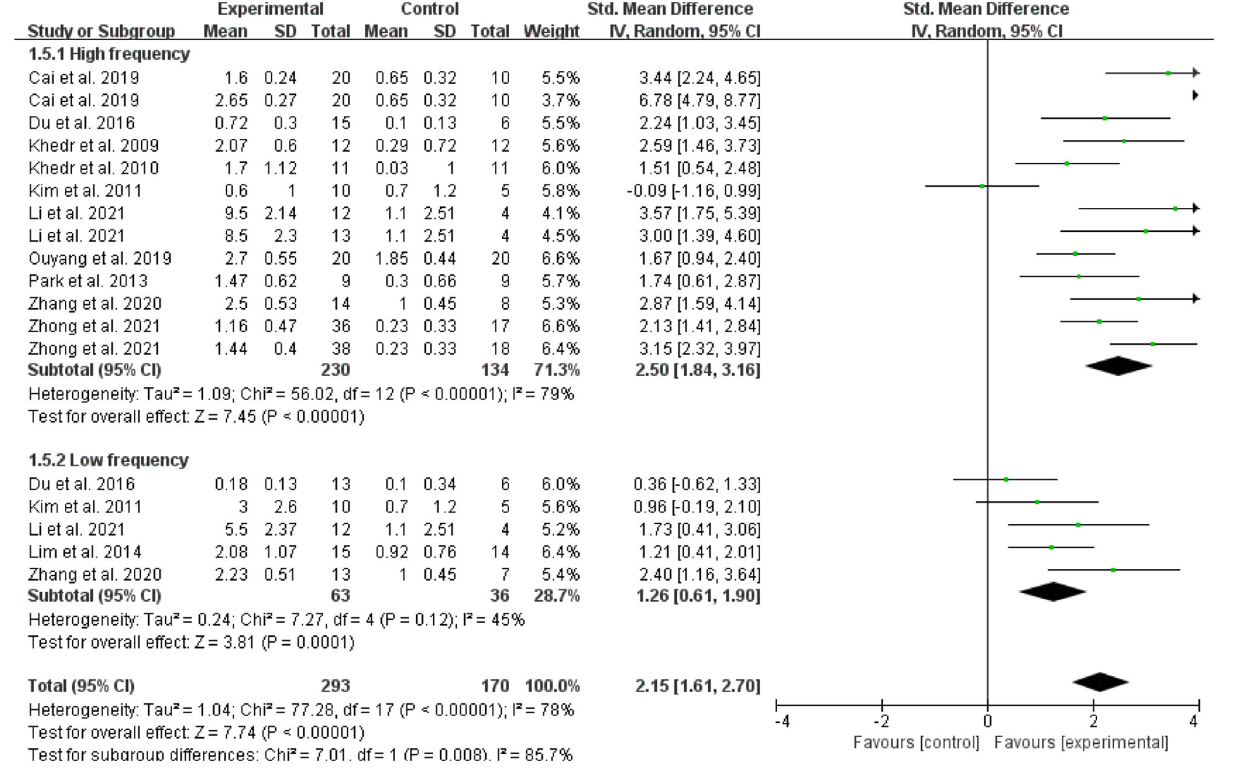
FIGURE 6 | Forest plot for subgroup analysis according to stimulation